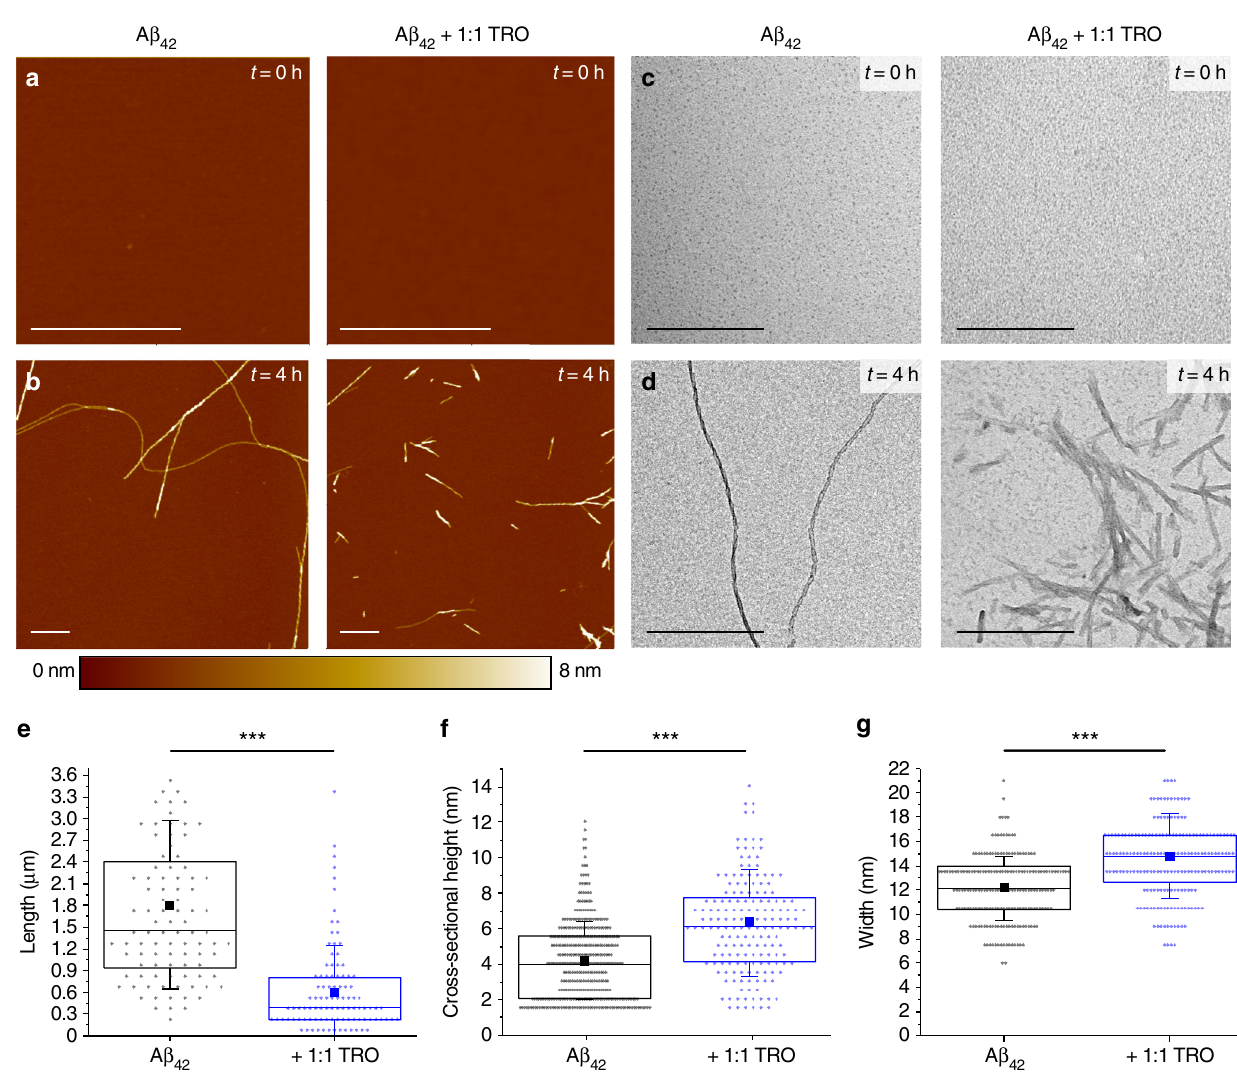
Fig. 2 Trodusquemine promotes the formation of shorter and thicker A β 42 fi brils in vitro. AFM ( a , b ) and TEM ( c , d ) measurements of A β 42 in the absence (left panels) or presence (right panels) of an equimolar concentration of trodusquemine. Samples were prepared at the initiation stage ( t = 0 h, a , c ) and in the plateau region ( t = 4 h, b , d ) of the aggregation reaction. Scale bars, 500 nm. AFM distributions of fi bril lengths ( e ) ( N = 100 per condition, *** P < 0.001 by paired t -test) and cross-sectional heights ( f ) ( N = 387 for A β 42 and N = 174 for A β 42 + 1:1 TRO, *** P < 0.001 by paired t -test), and TEM widths ( g ) ( N = 200 per condition, *** P < 0.001 by paired t -test) in the absence (black) and presence (blue) of trodusquemine. In e – g the square denotes the mean, the centre line indicates the median, the bounds of the boxes indicate the fi rst and third quartiles containing 50% of the data, and the whiskers indicate the fi rst standard